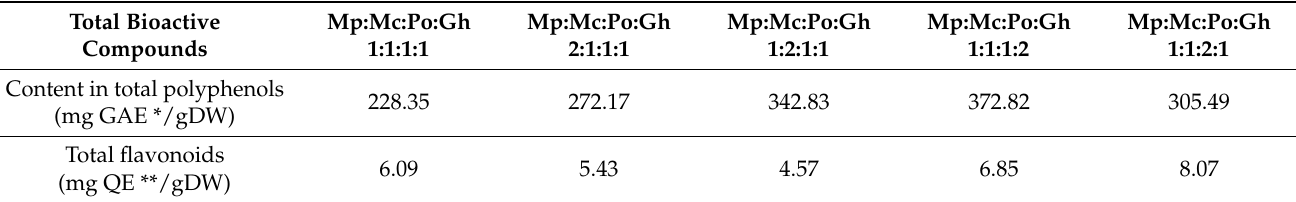
Table 1. The content of polyphenols and flavonoids in the mixture of extracts: Mentha piperita Huds. (Mp) , Matricaria chamomilla L. (Mc), Polygonum aviculare L. (Po), and Glechoma hederacea L. (Gh), in different proportions Mp:Mc:Po:Gh., 1:1:1:1; 2:1:1:1; 1:1:1:2, and 1:1:2:1. Total Bioactive